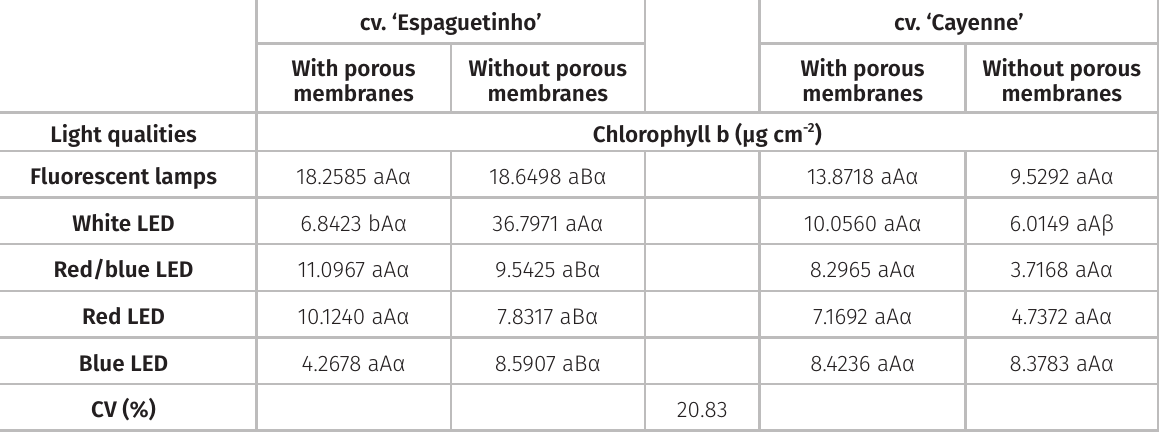
Table IV. Chlorophyll b contents of Capsicum frutescens cultivars (‘Espaguetinho’ and ‘Cayenne’) cultivated under different light qualities and types of sealing.